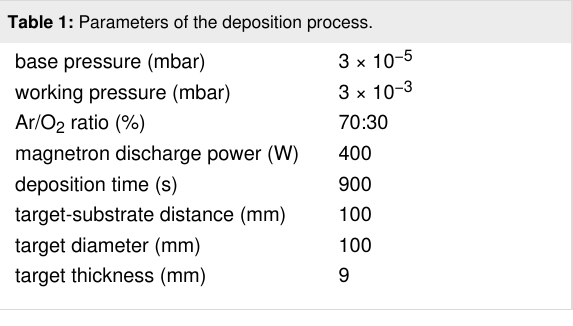
Table 1: Parameters of the deposition